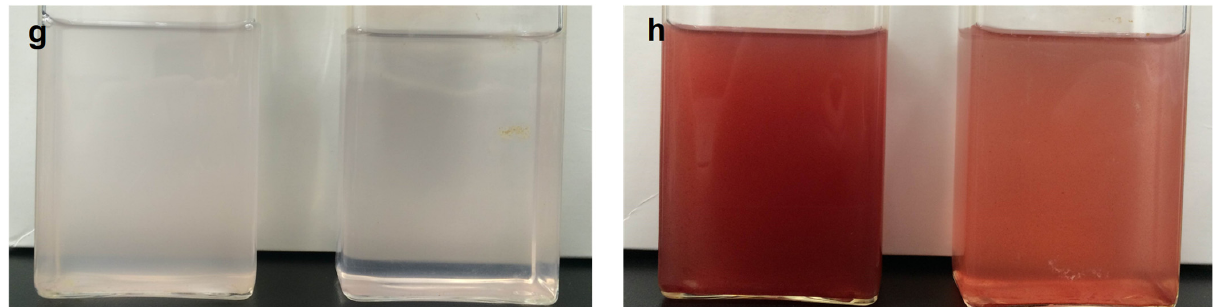
Figure 4. Diazotrophic growth and biofilm formation in the co-culture of R. palustris CGA009 and B. subtilis ATCC6633 in the presence of air. Microscopic observation of the co-culture after 1 day ( a ), 3 days ( b ), 4 days ( c ), 5 days ( d ), 6 days ( e ), and 7 days ( f ). R. palustris (blue–green) cells were stained with malachite green, and B. subtilis (red) cells were stained with safranin. After a versatile stain with malachite green [136] , safranin replaced the malachite green in B. subtilis vegetative cells [137] . R. palustris pure culture (right) and the co-culture (left) after inoculation ( g ) and 7 days ( h ) are shown.